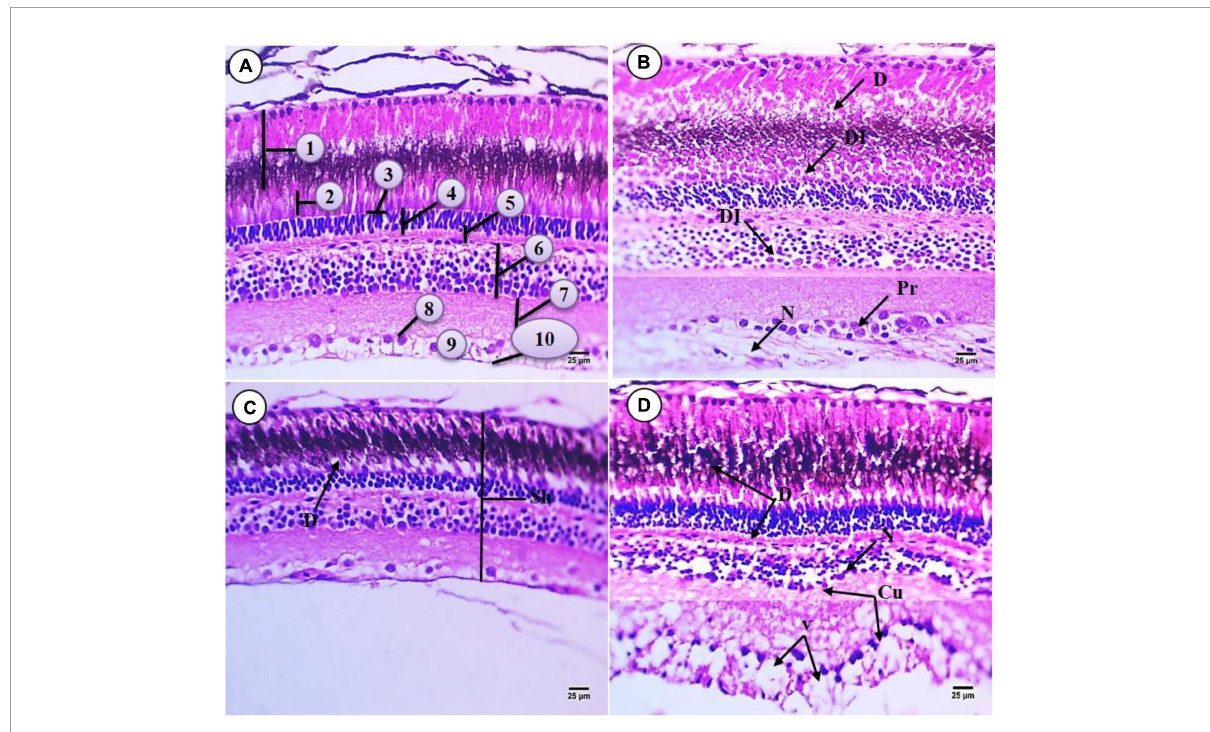
FIGURE3 Sections of retina of control and treated fish Cyprinus carpio ; (A) sections of control fish retina showing retinal layer: (1) RPE mostly contains melanin, (2) photoreceptor layer (PL) (rod and cone processes), (3) outer liming membrane (OLM), (4) outer nuclear layer (ONL) consisting of the nuclei of the photoreceptors, (5) OPL, (6) INL, (7) inner plexiform layer (IPL), (8) GL, (9) NFL, (10) internal liming membrane (ILM); (B) exposure to 100 mg/L of macroplastic for 15 days showing necrosis (N), degeneration (D), disintegrated (DI) and proliferation (Pr); (C) exposure to 100 mg/L of microplastic for 15 days showing shrunken (Sh) in retinal layer and degeneration (D); (D) exposure to 100 mg/L of nanoplastic for 15 days showing necrosis (N), degeneration (D), vacuolation (V) and curved in inner layer (Cu) (H&E × 400) .